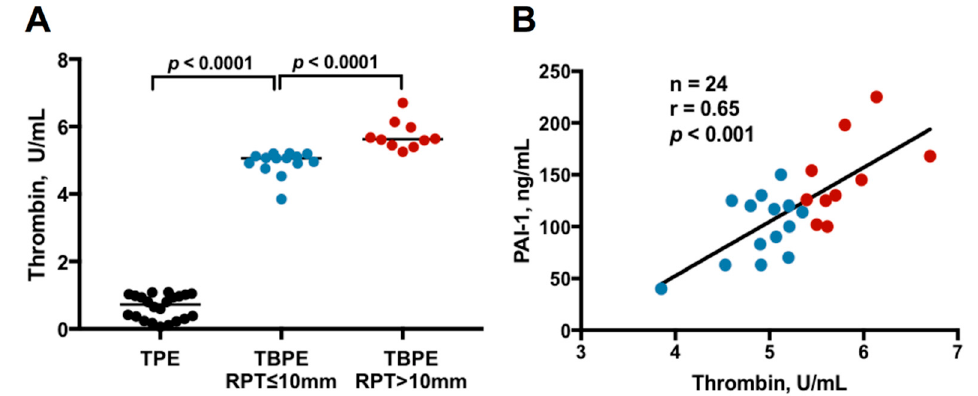
Figure 1. Thrombin levels among TPE, TBPE with RPT ≤ 10 mm and TBPE with RPT > 10 mm groups and the correlation between thrombin and PAI-1 in TBPE ( A ) Pleural e ff usion thrombin levels were significantly higher in TBPE than in TPE and were markedly higher in TBPE patients with RPT > 10 mm than in those with RPT 10 mm. ( B ) Pleural e ff usion thrombin levels were positively correlated with those of PAI-1 in TBPE. TPE, transudative pleural e ff usion ( n = 22); TBPE, tuberculous pleural e ff usion (total n = 24); RPT, residual pleural thickening; PAI-1, plasminogen activator inhibitor-1. Blue dot, TBPE with RPT 10 mm ( n = 14); Red dot, TBPE with RPT > 10 mm ( n = ≤